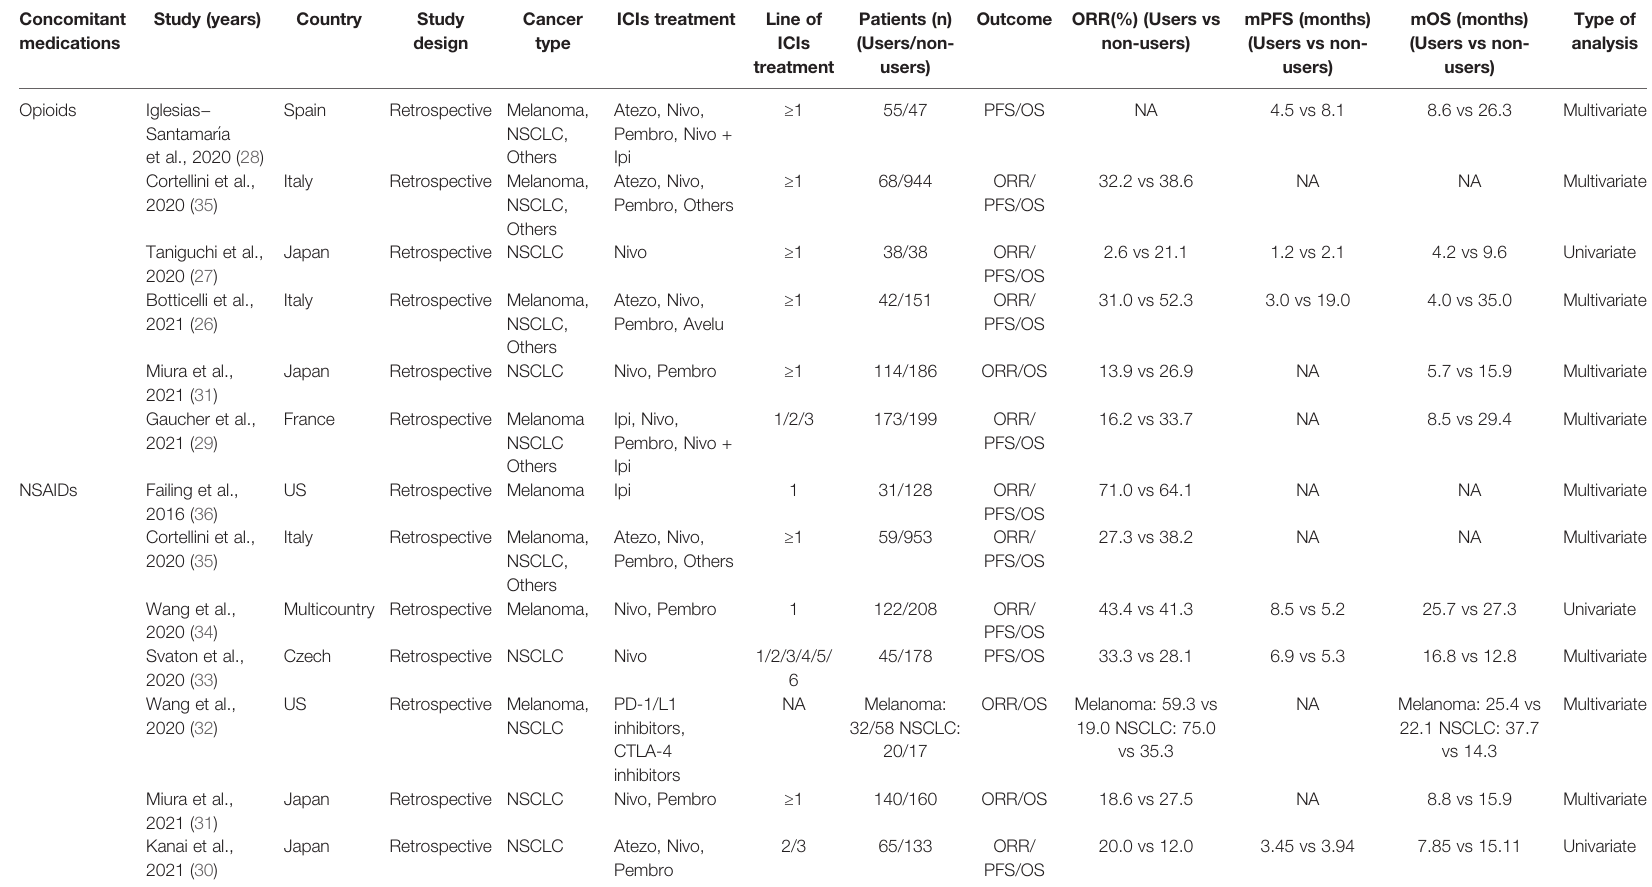
TABLE 1 | Baseline characteristics of studies included in the